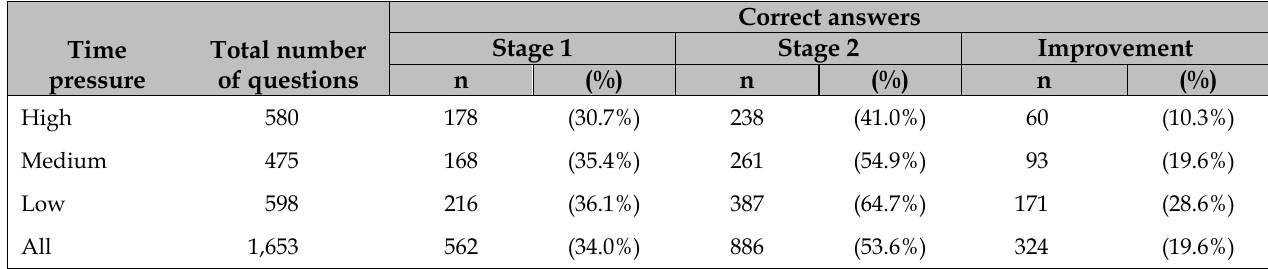
Table 1 Number of questions answered correctly in stages 1 and 2 and improvement across stages according to time